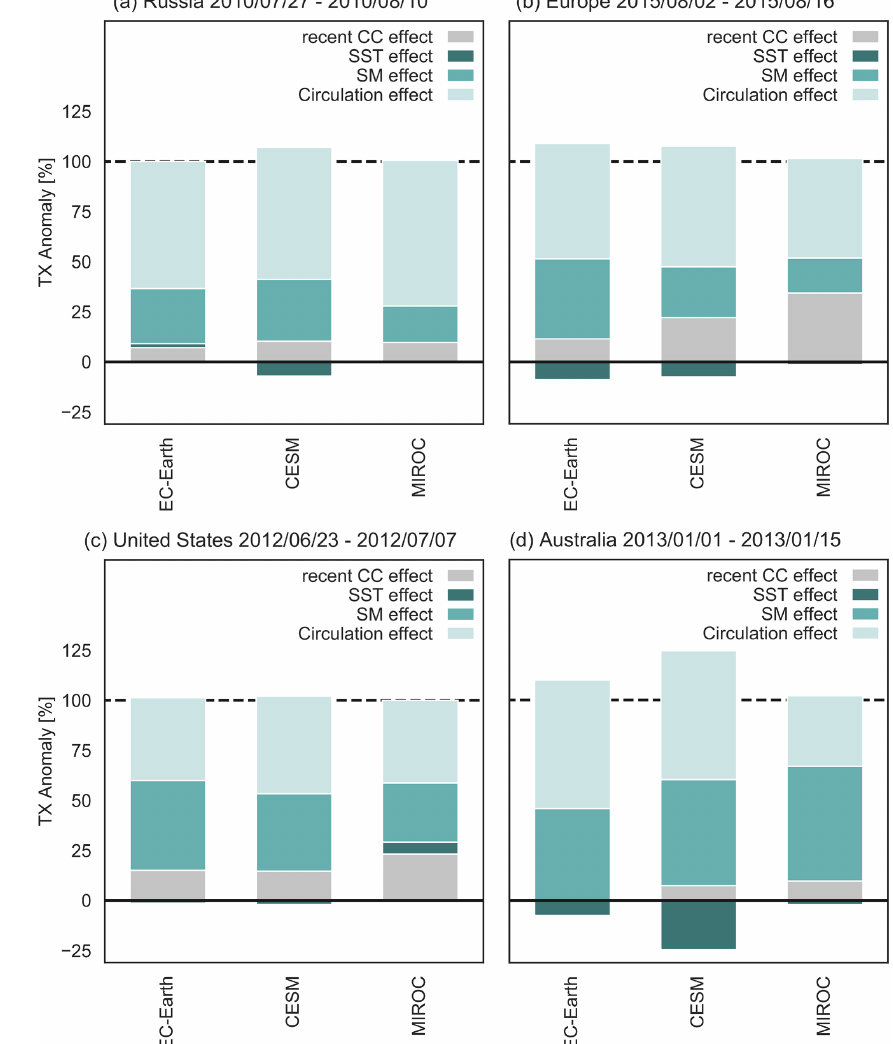
Figure 7. Contribution of recent climate change (since the 1982–2008 base period) and physical drivers to the daily maximum temperature (TX) anomaly during 4 recent events: (a) Russia 2010, (b) Europe 2015, (c) United States 2012, (d) Australian summer 2012/13. The dates of the hottest consecutive 15d period are given in the label of each subplot. The contributions of the drivers are normalized by the climatology of AF_SF for each model. The two approaches to compute SM vs. ATM contribution are merged, giving equal weight to